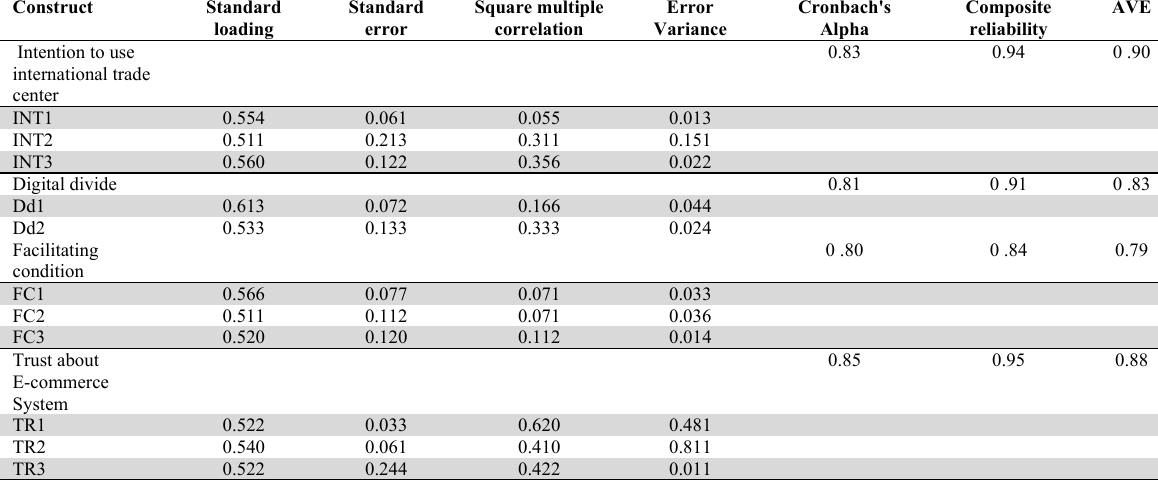
Properties of the measurement model